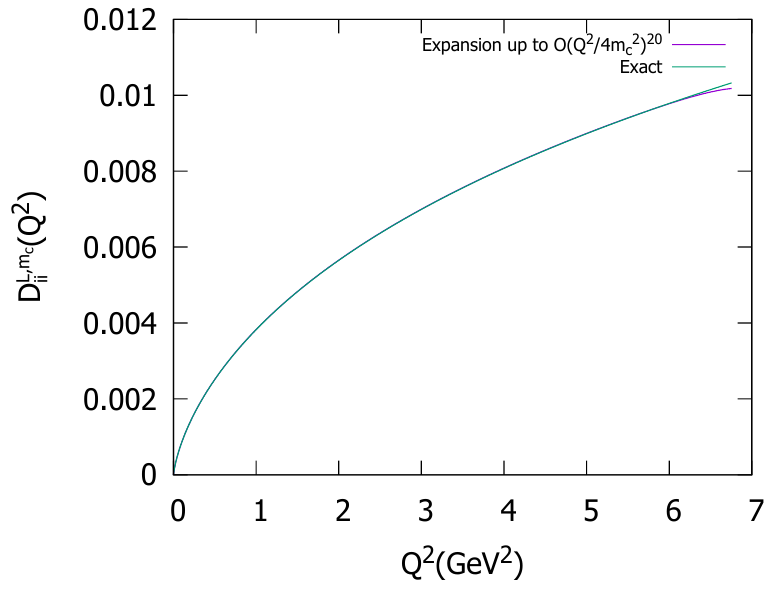
Figure 6 . Comparison between D L,m c computed analytically, using the expansions and performing an expansion in Q 2 / 4 m 2 The input value α ( n f =5) s ( M 2